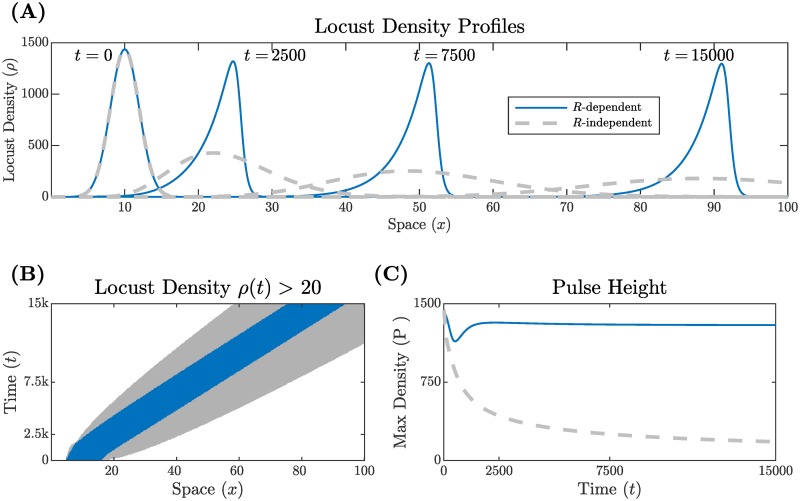
Locust density profiles with R-dependent (solid blue line) and R-independent (dashed gray line) switching rates.Each profile evolves from the same initial condition. (A) Shows snapshots of the density profiles over distance and time for both types of switching rates. (B) Illustrates the width of the bands where color represents a locust density greater than 20. (C) Displays the peak density of each pulse over time.